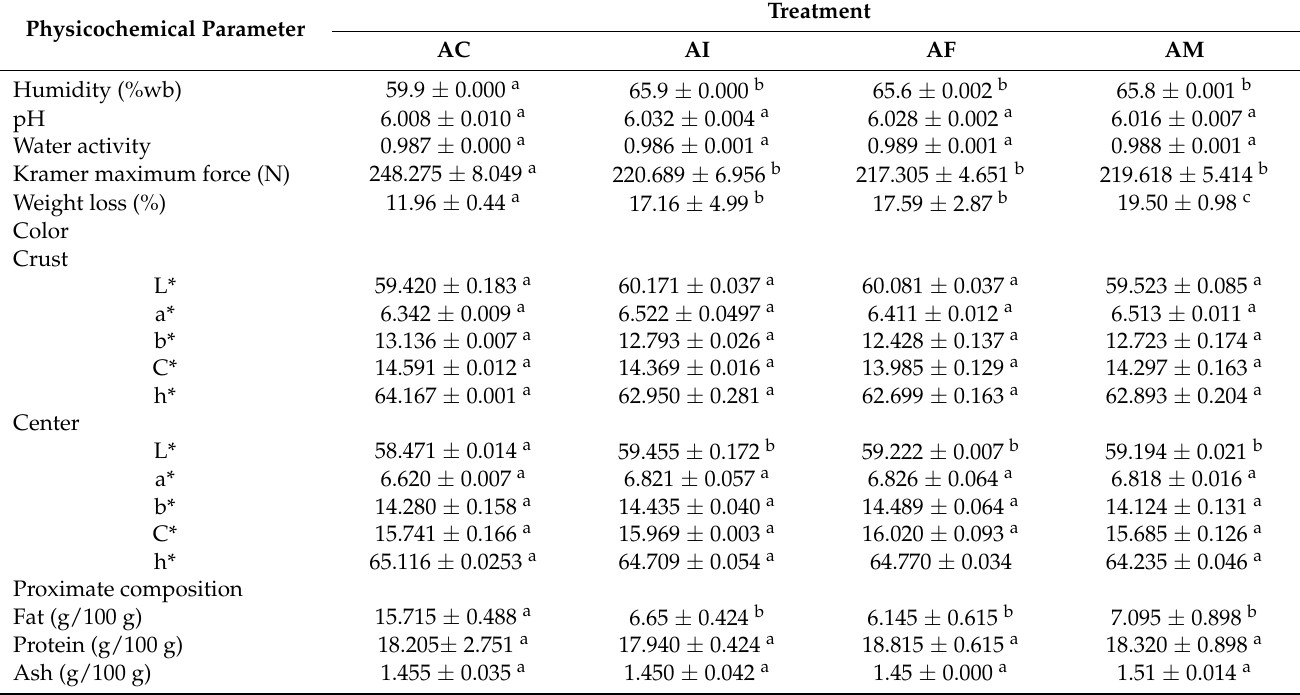
Table 6. Physicochemical pork and chicken meatball parameters.